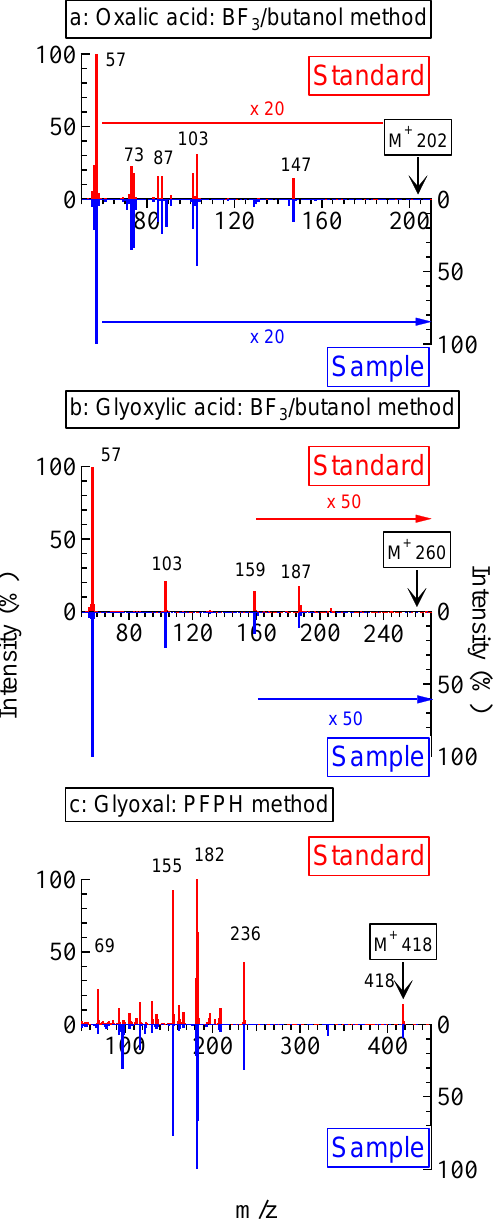
Fig. 5. Mass spectra of some of the products identified by UPLC- Figure 5. Mass spectra of selected products identified by UPLC-ESI-ToF-MS under condition (B). 2 ESI-ToF-MS under condition (B). Mass spectra of other products identified by UPLC-ESI-ToF-MS can be found in Fig. S12 in the Mass spectra of other products by UPLC-ESI-ToF-MS can be found in Figure S12 in the Supporting 3 Supplement. Information. 4